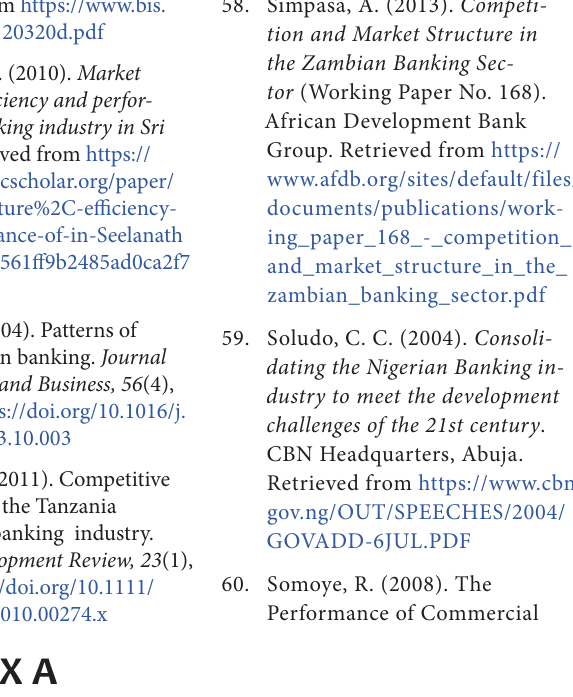
Table A1. Years of recapitalization and respective new minimum bank capital No.